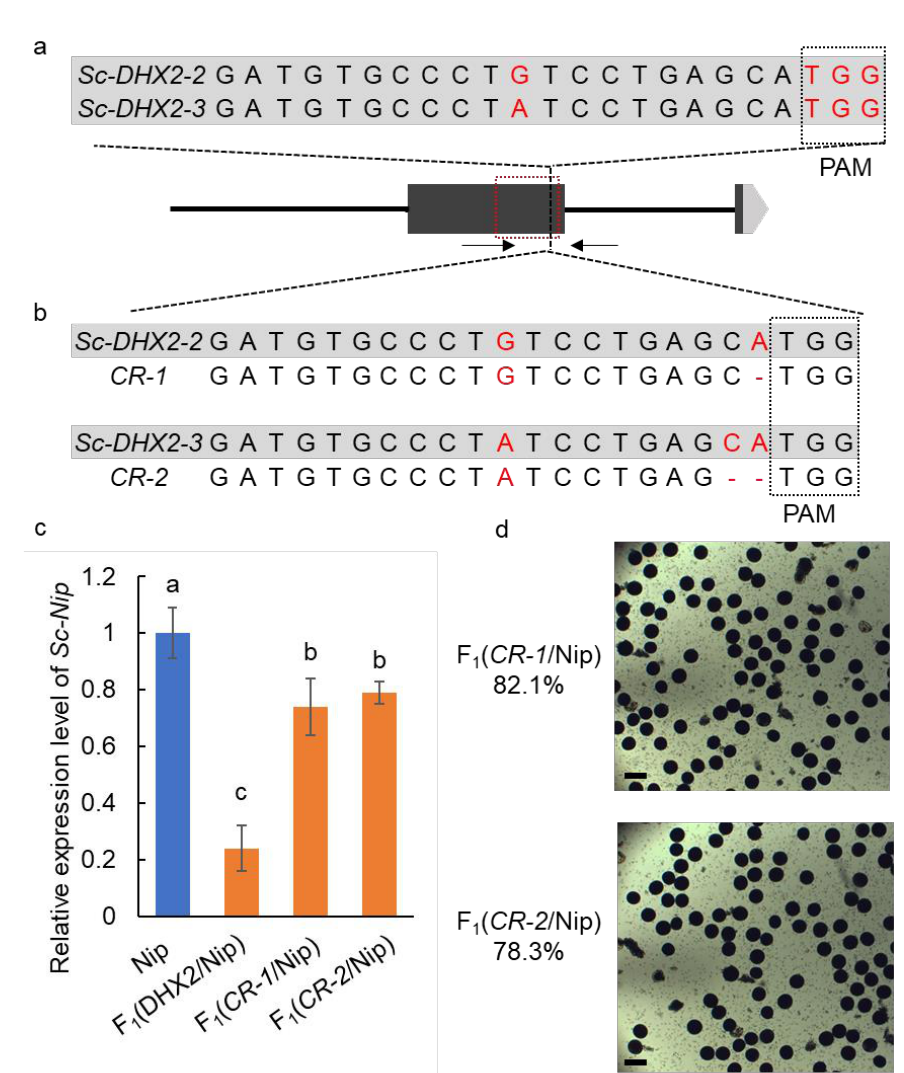
Figure 3. The CRISPR/Cas9 gene editing of the extra copy of Sc in DHX2. ( a ) The sgRNA sequence of Sc-DHX2-2 and Sc-DHX2-3 . The red dash line box indicates the DUF1618 domain; ( b ) the sequence of two mutant lines; ( c ) the expression level of Sc-Nip in the anthers of the F 1 plants. Different letters denote significant differences ( p < 0.05) from Duncan’s multiple range tests; ( d ) the pollen phenotypes of F 1 plants derived from the cross of CR-1 /Nip and CR-2 /Nip. Scale bar: 50 μm.